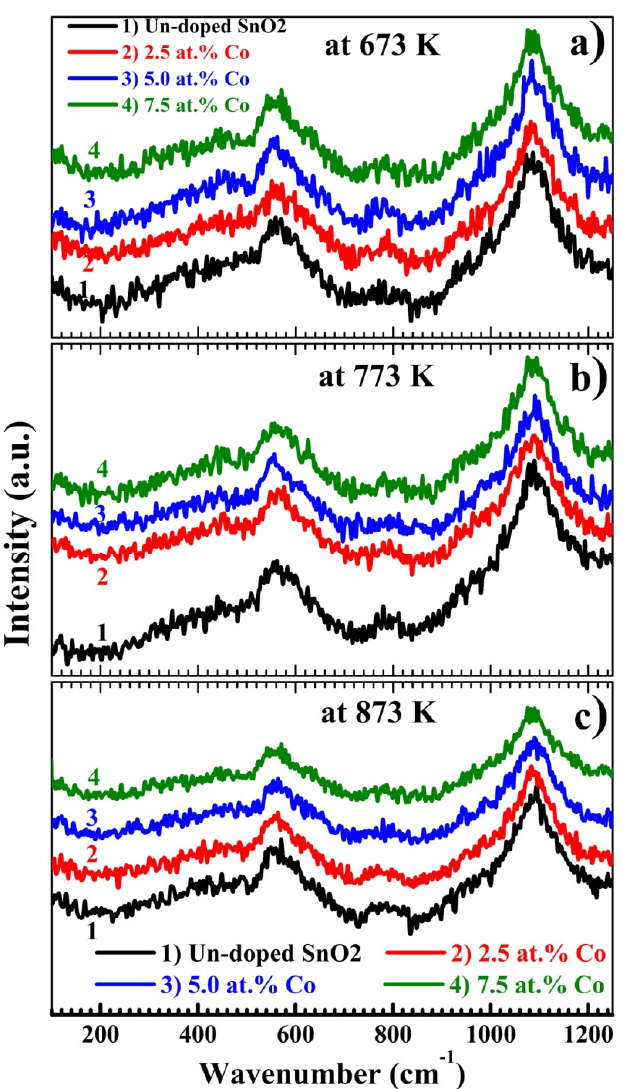
Figure 3. ( a – c ): Raman spectra of pure and doped tin oxide films at different CT.